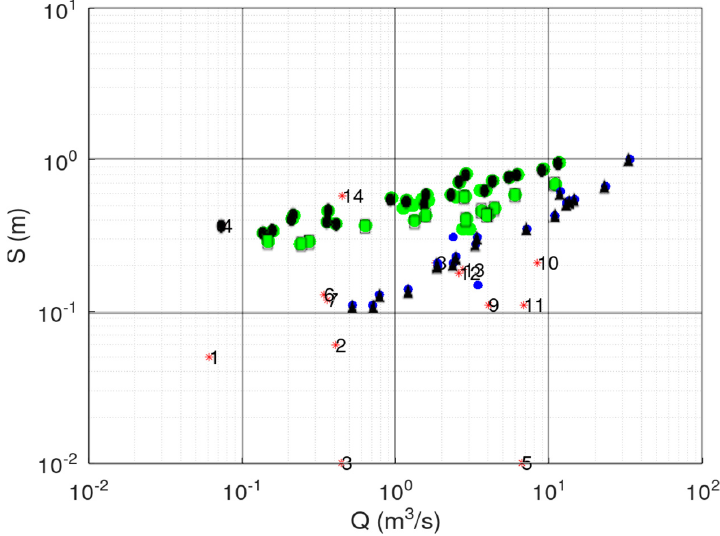
Figure 7. Sakoulevas case study—scatter plot of stage vs. discharge. DBSCAN: period 1 (02/1964– 04/1966) with blue dots, period 2 (05/1966–01/1972) with green dots, outliers with red stars. PINAX: period 1 (02/1964–05/1966) with triangles, period 2 (06/1966–05/1969) with black dots, and period 3 (06/1969–01/1972) with